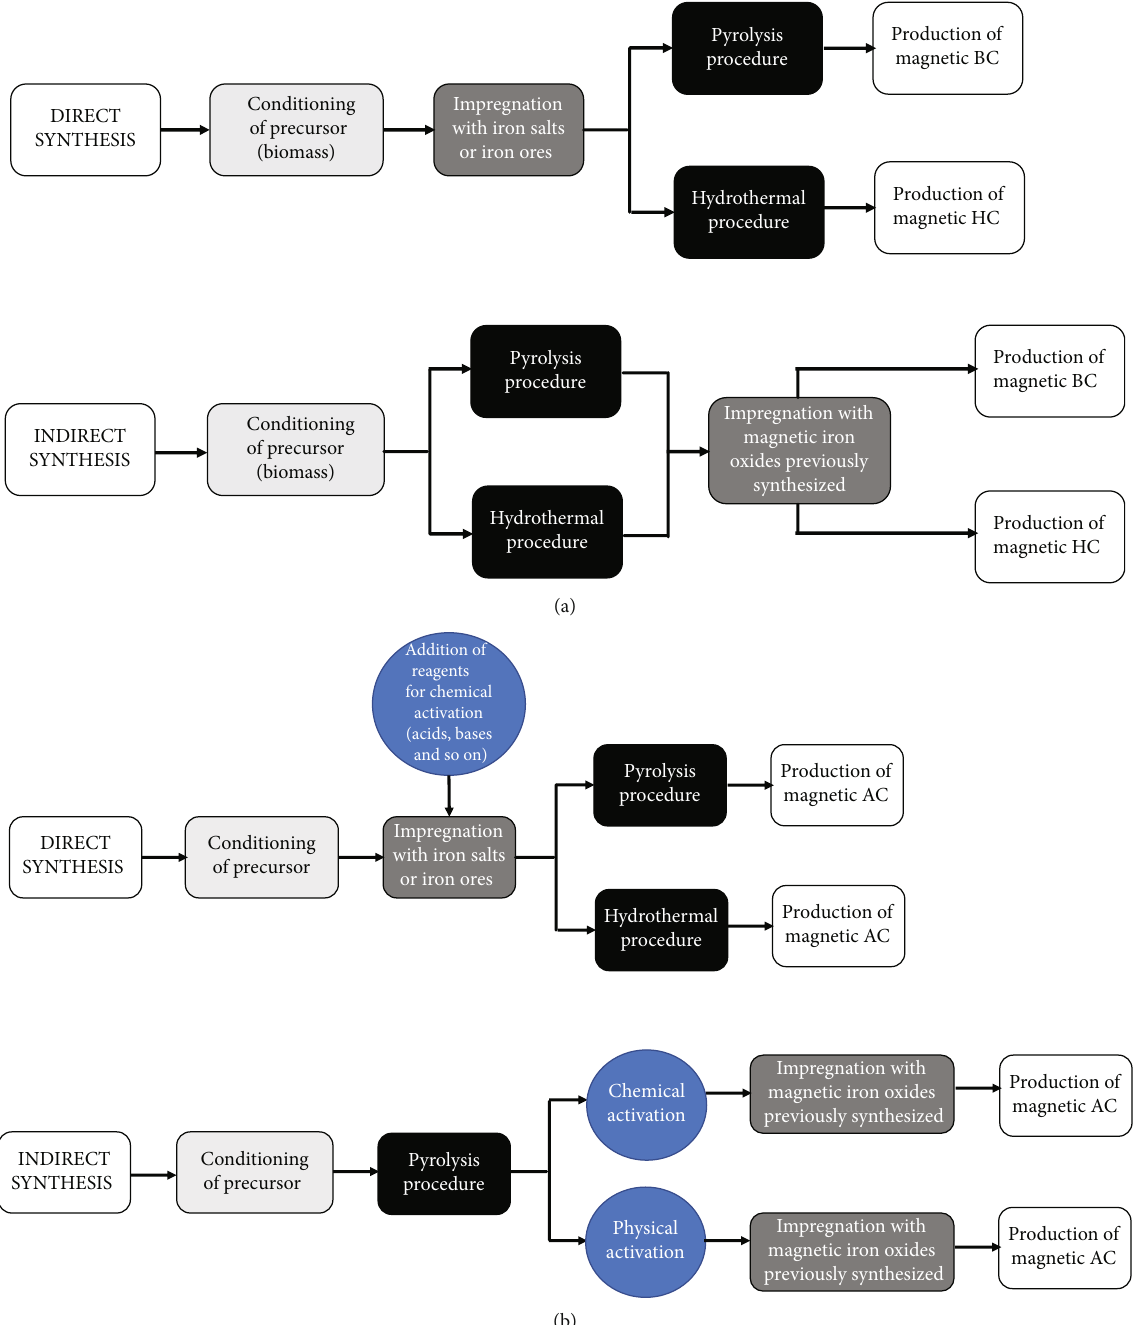
Figure 2: General steps for the preparation of: (a) magnetic hydrochar (HC) and magnetic biochar (BC) by direct or indirect synthesis and (b) magnetic activated carbon (AC) by direct or indirect